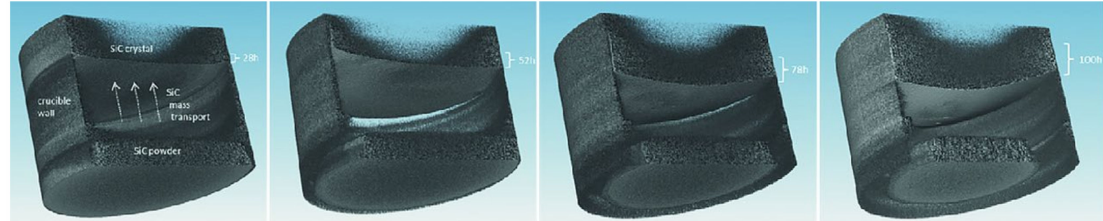
Figure 7. 3D in situ x-ray visualization of the PVT growth process using computed tomography: detailed visualization of the crystal’s growth interface [113].